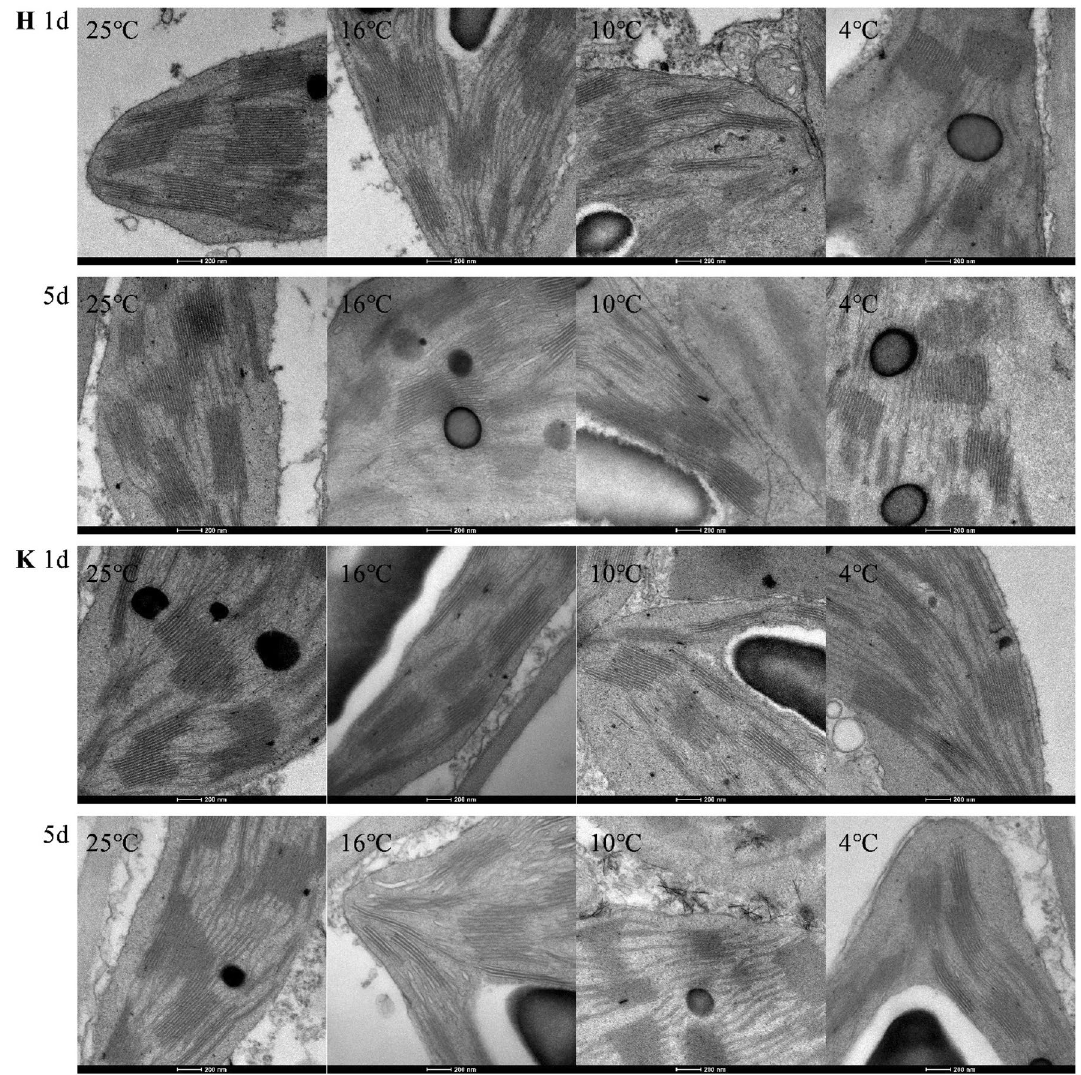
Figure 2. Effects of low-temperature stress on ultrastructures of grana lamellae of chloroplasts in tobacco leaves. "H" means Honghuadajinyuan variety, and "K" means K326 variety.